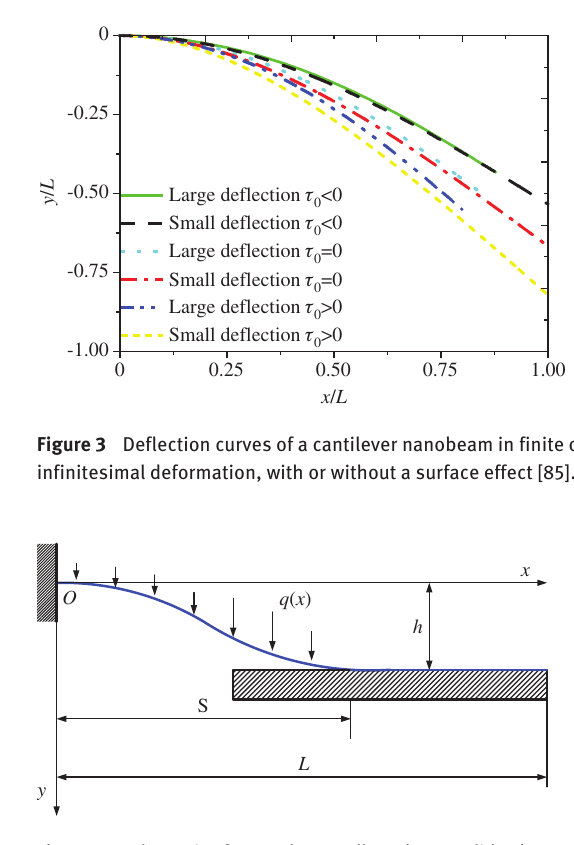
Figure 4 Schematic of a nanobeam adhered on a solid substrate